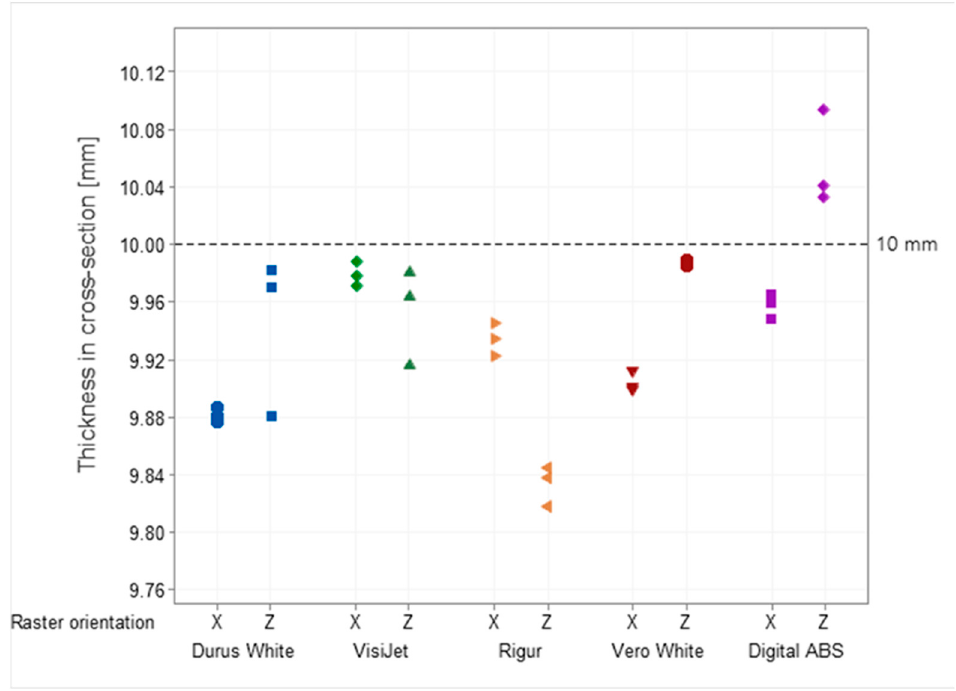
Figure 4. Results of cross-sectional thickness measurements obtained for Durus, VisiJet, Rigur, Vero, and ABS materials.